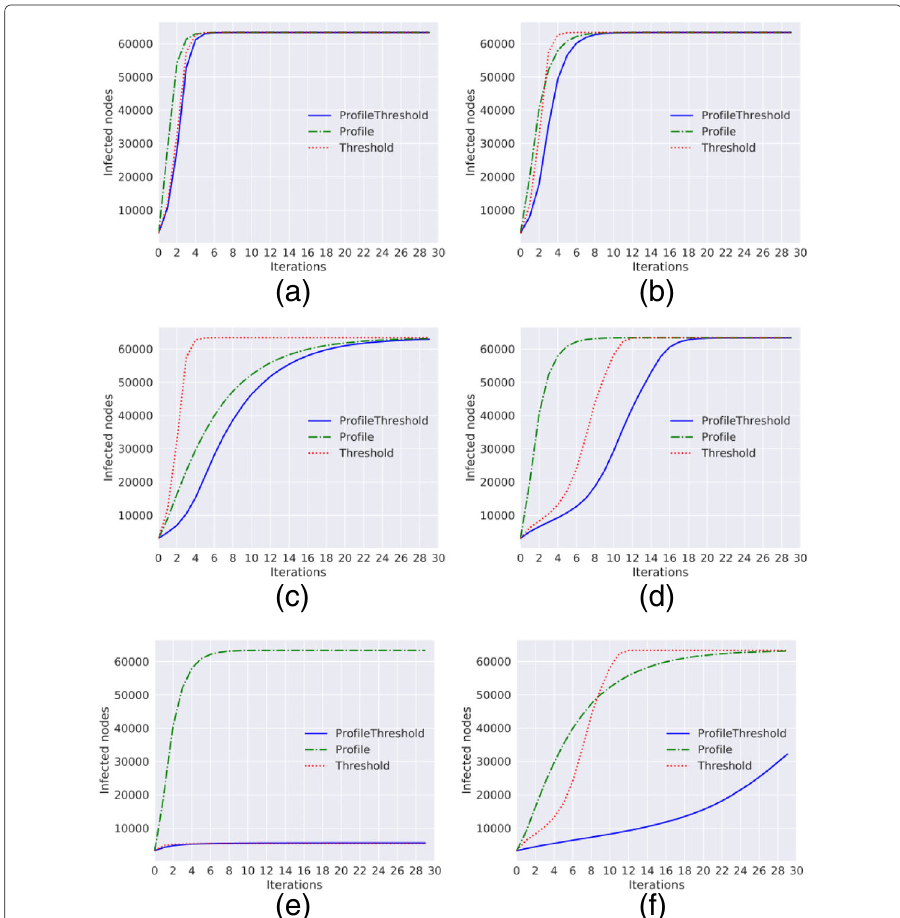
Fig. 4 Diffusion trends for the Facebook graph. Diffusion trends for Threshold , ProfileThreshold and Profile model with a = 0 and p = 0 and with different values of γ and τ . a γ = 0.1, τ = 0.1 b γ = 0.4, τ = 0.1 c γ = 0.8, τ = 0.1 d γ = 0.4, τ = 0.2 e γ = 0.4, τ = 0.3 f γ = 0.8, τ =